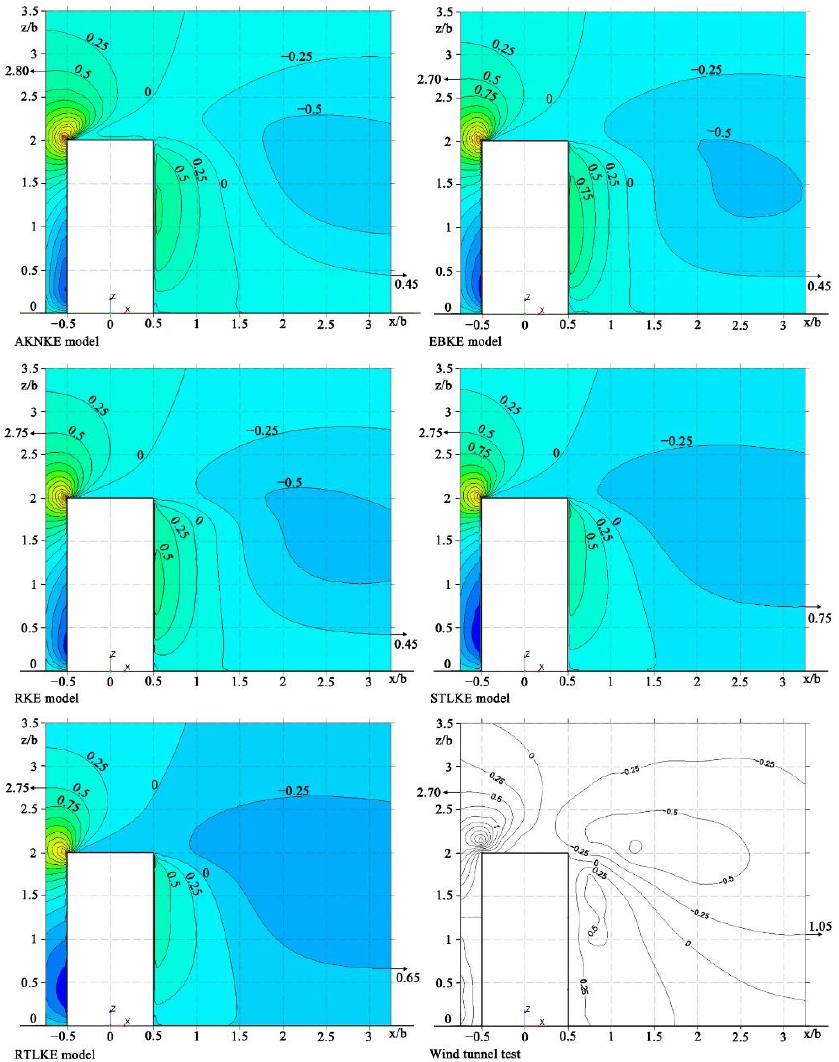
Figure 10. Contour plots of Z-velocity ( W ) at Y = 0.